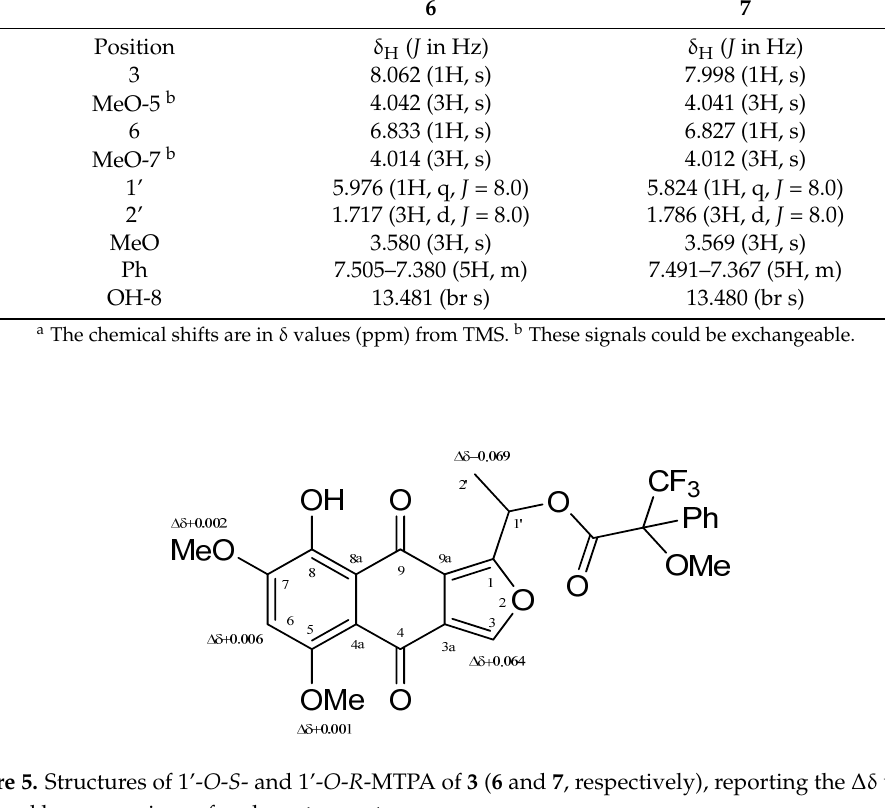
Table 1. 1 H ‐ NMR data of 6 and 7 recoded in CDCl 3 a.